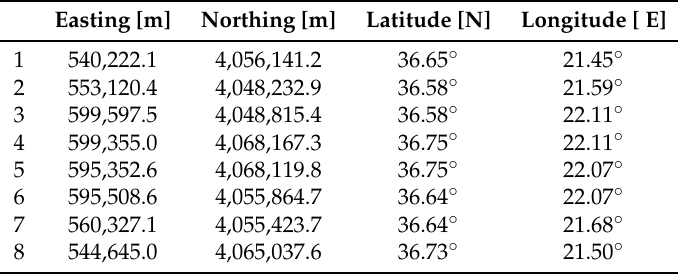
Table 3. The coordinates of the points delimiting the boundaries of the main survey area (500 km 2 ) to be mapped by the teams participating in the Final Round of Shell Ocean Discovery XPRIZE (WGS84 Spheroid, WGS84 Datum, UTM Projection coordinates refer to Zone 34 North).